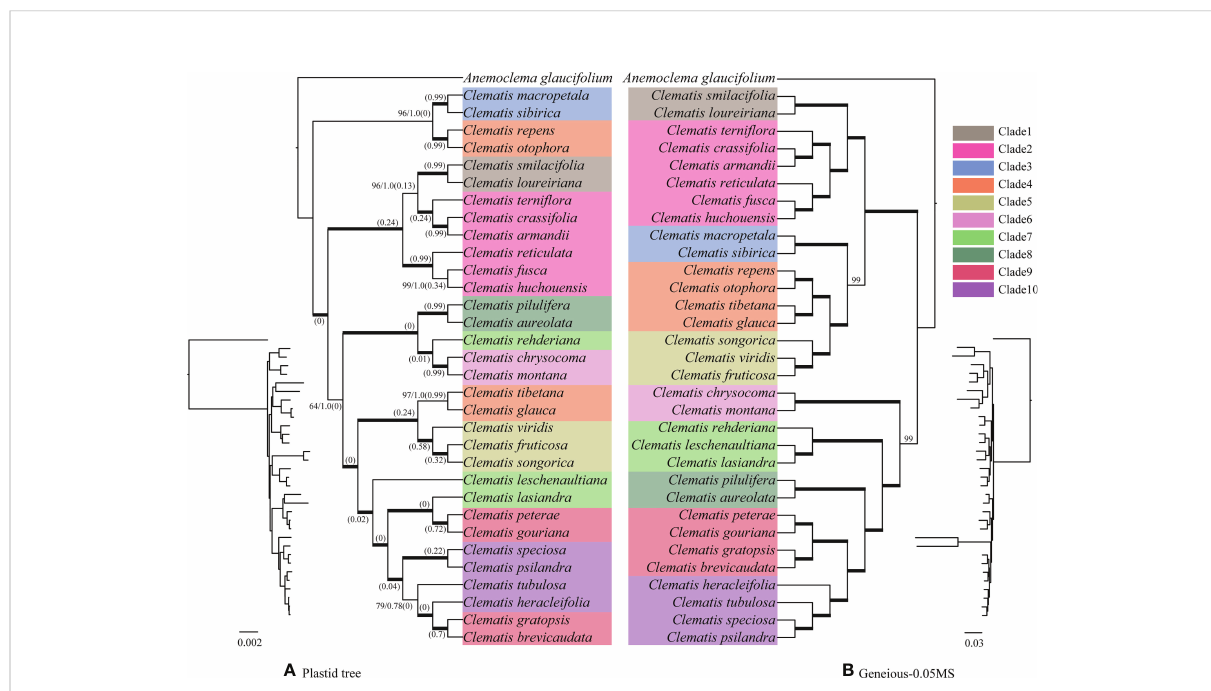
FIGURE 2 Bayesian phylogeny (A) of Clematis inferred from the plastid genome data and maximum likelihood phylogeny (B) inferred from nuclear SNPs of Geneious-0.05MS dataset. Cyto-nuclear con fl icts are shown. In the plastid phylogeny (A) , bold branches show that the clades are 100% supported by both posteriori probability and ML bootstrap values. Otherwise, these two statistical values were marked on the branches. Numbers in brackets show the contribution of incomplete lineage sorting (ILS) to the con fl icts between the simulated and plastid gene trees based on the multispecies coalescent model. Ten major clades were marked on the nuclear SNPs tree (B) with different colors. Species in plastid tree were marked with the same color with those in the nuclear SNPs